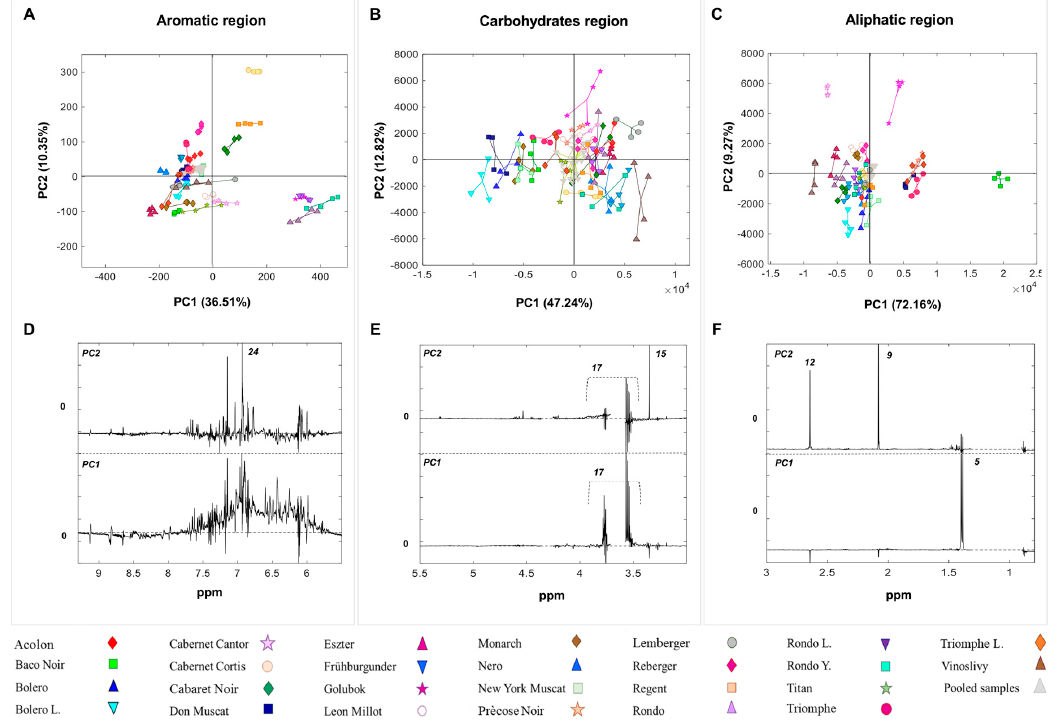
Figure 2. Scores and loadings plots of the PCA on the aliphatic (0.80–3 ppm) ( C – F ); carbohydrates (3.01–5.50 ppm) ( B – E ), and aromatic (5.51–9.30) ( A – D ) regions of the 1 H-NMR spectra from wet wines. The explained variance, for each principal component, is reported in parenthesis.